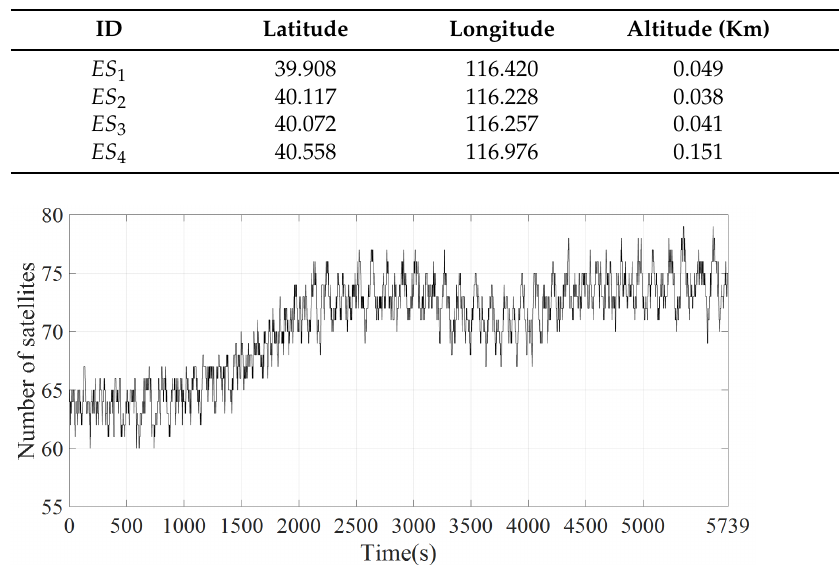
Figure 8. The number of satellites accessible to ES 1 varies over